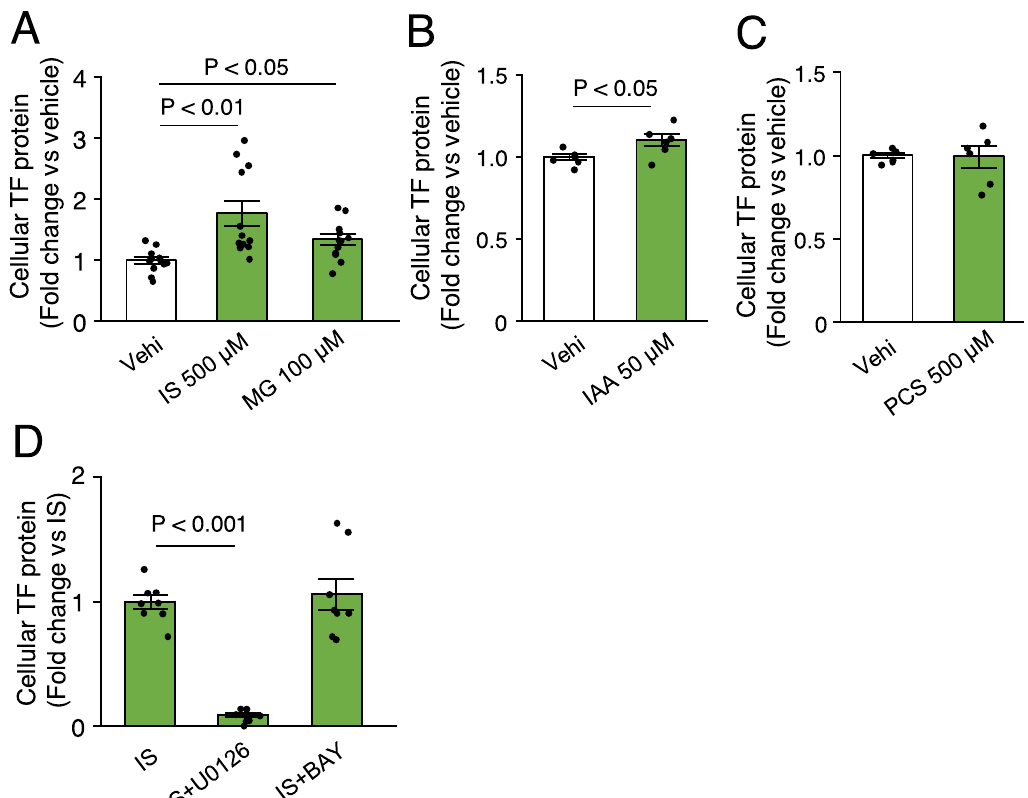
Figure 2. Effect of uremic toxins on TF expression in monocytic THP-1 cells. ( A–B ). Treatment with indoxyl sulfate (IS), methylglyoxal (MG), and indole-3-acetic acid (IAA) for 24 h increased the expression of TF protein in THP-1 cells. ( C ) Treatment with p-cresyl sulfate (PCS) did not affect the expression of TF protein in THP-1 cells. ( D ) Elevation of TF protein levels induced by IS was reduced by U-0126, but not by Bay 11–7082 (BAY). n = 6–8. vehi, vehicle. Data are shown as the mean ± SEM.